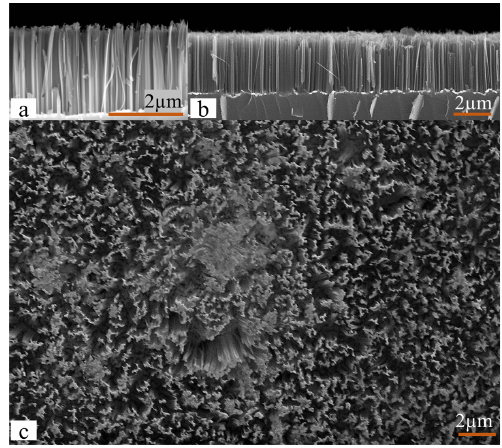
Figure 1. SEM image of SiNWs etched for 7min ( a ), high-magnification cross-section of the same image ( b ), and ( c ) top-view SEM image of SiNWs etched for